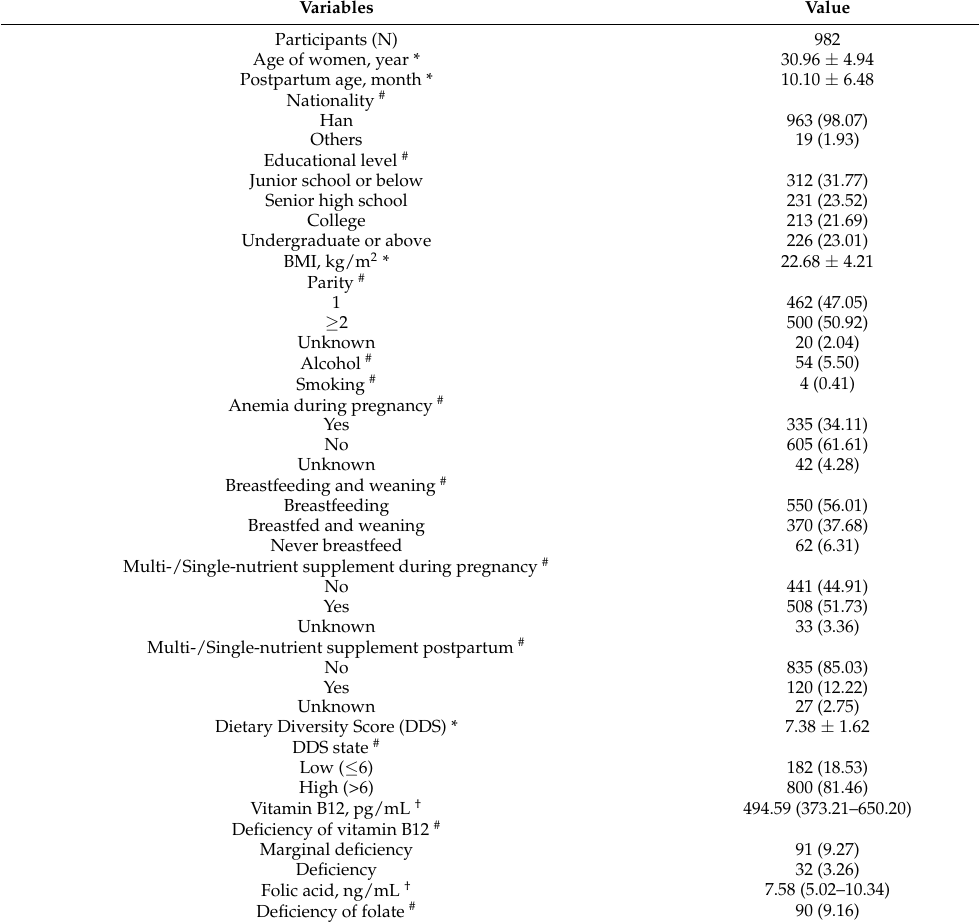
Table 1. Basic characteristics of women within 2 years